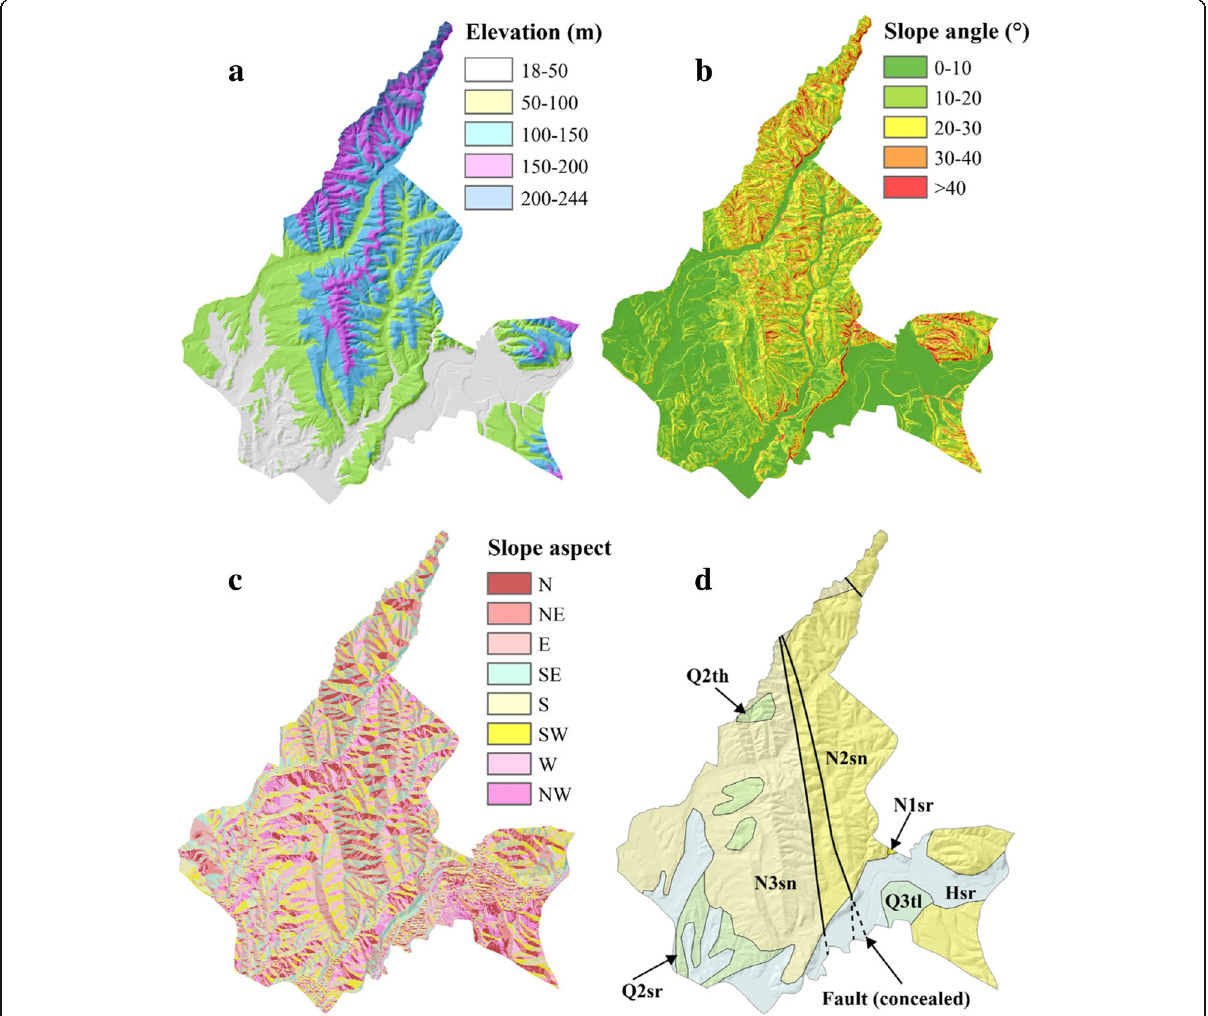
Fig. 2 Topographic and geological information of the study area ( a ) Elevation. b Slope angle. c Slope aspect. d Geological map (based on